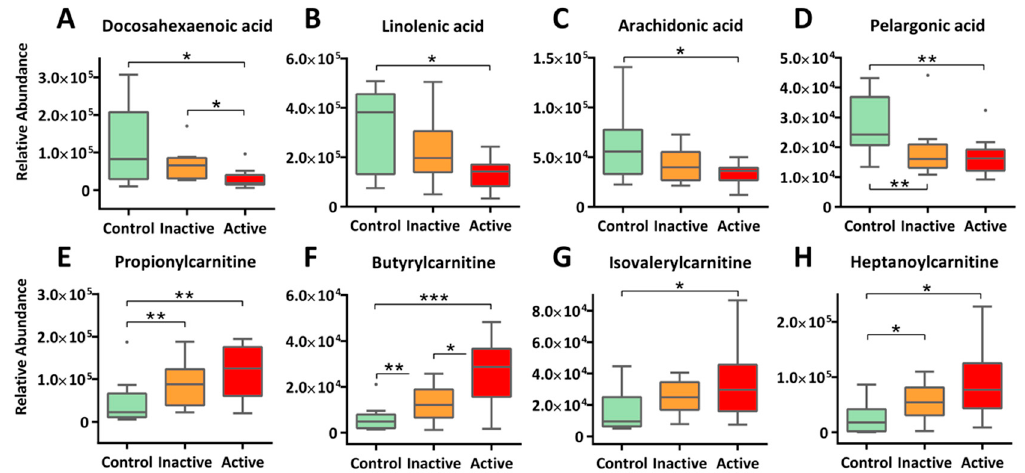
Figure 3. Enhanced β -oxidation of fatty acids and altered lipid signaling cascades is observed in Crohn’s patients, as evidenced by decreasing long-chain fatty acids ( A–C ) and medium-chain fatty acids ( D ), as well as increasing acylcarnitine ( E–H ) in blood circulation. The y -axis measures the peak height of the profiled metabolites, and the x -axis marks the three IBD groups for comparison, namely control (green), inactive (orange), and active (red), outliers, represented as dots, were excluded from comparison. *** p < 0.001, ** p < 0.01, * p < 0.05.